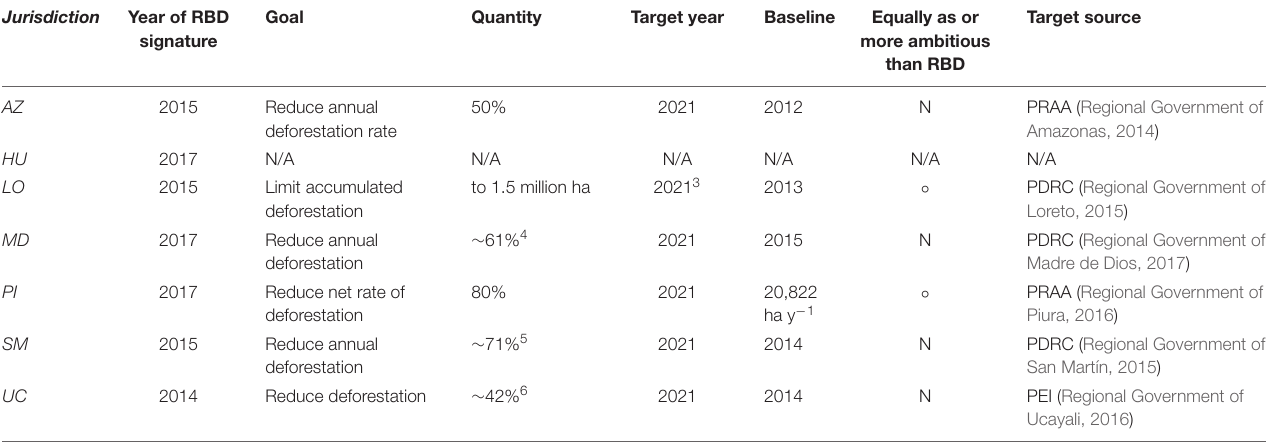
TABLE 5 | Inventory of deforestation targets (“legal targets”) of the seven GCF TF member jurisdictions located in